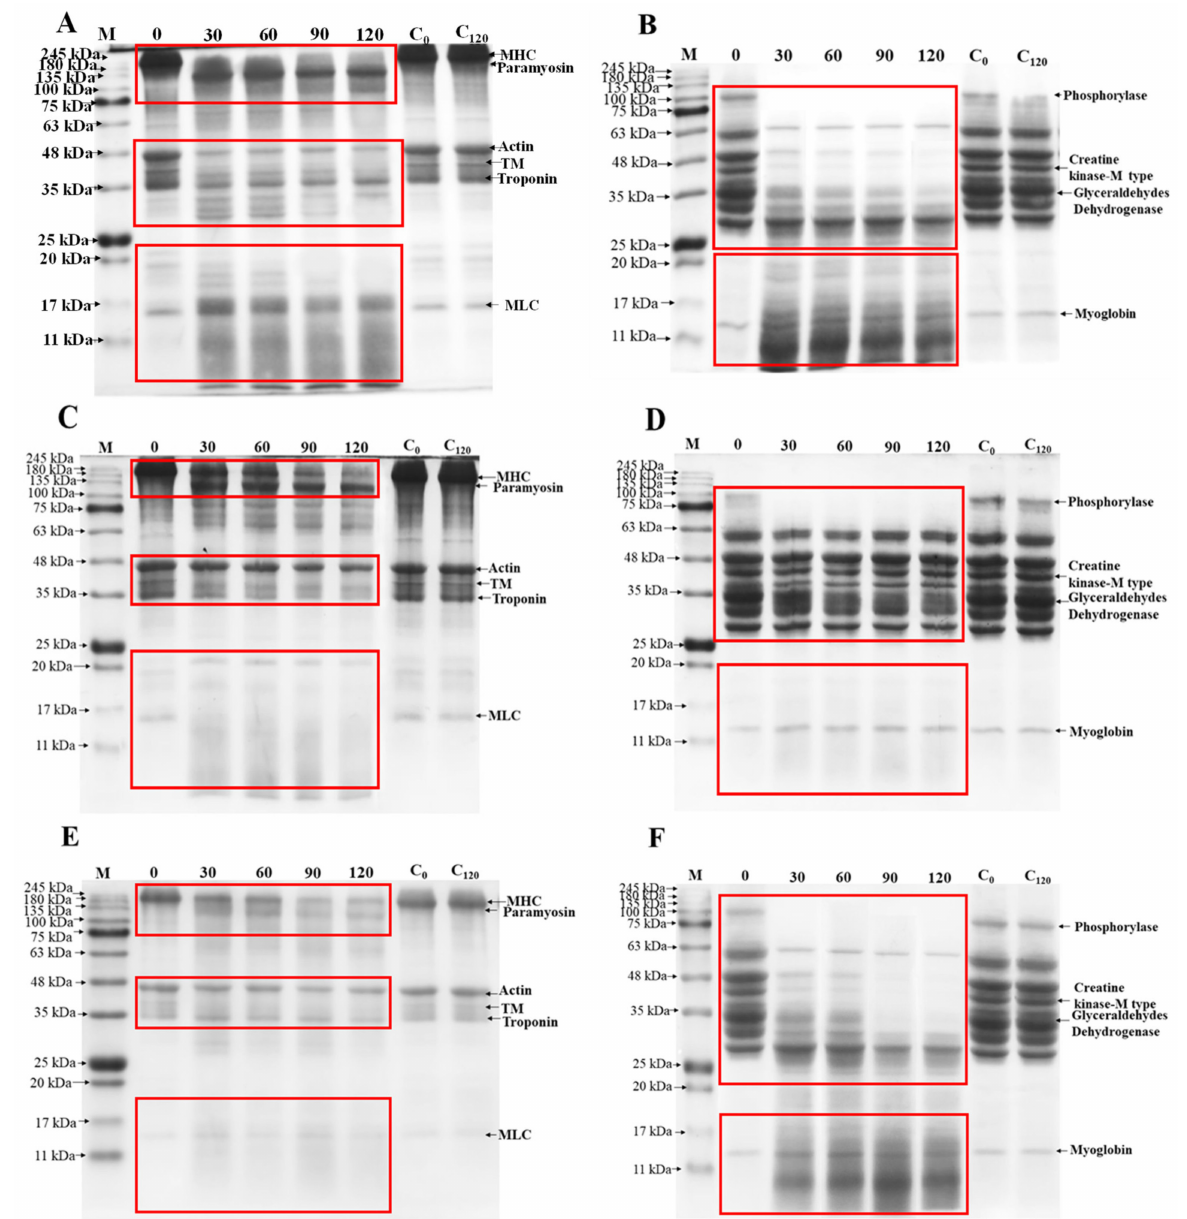
Figure 5. Enzymatic hydrolysis of myofibrillar ( A ) and sarcoplasmic proteins ( B ) by the S. xylosus A2 protease. Enzymatic hydrolysis of myofibrillar ( C ) and sarcoplasmic proteins ( D ) by trypsin. Enzymatic hydrolysis of myofibrillar ( E ) and sarcoplasmic proteins ( F ) by papain. C 0 and C 120 refer to myofibrillar and sarcoplasmic proteins incubated with ultrapure water for 0 and 120 min under the same conditions. M refers to the molecular weight of the protein standard; MHC refers to myosin heavy chain; TM refers to tropomyosin; MLC refers to myosin light